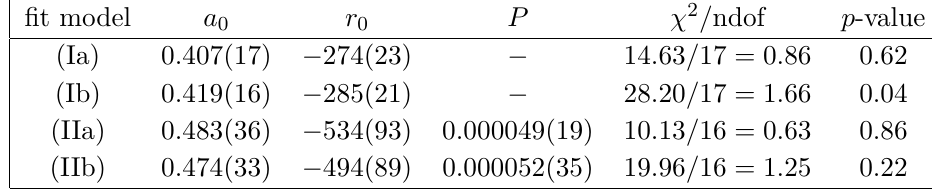
Table 7. Results from the different S -wave phase-shift fits to the complete set of data